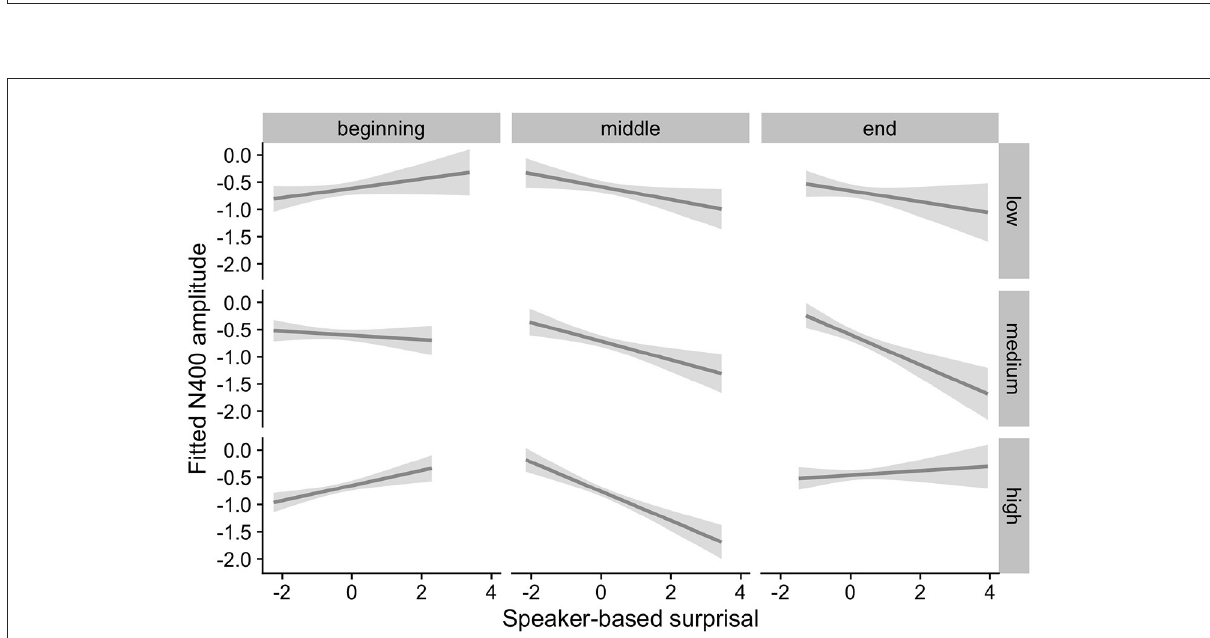
FIGURE8 Effects of IAF on changes in the relationship between speaker-based surprisal (z-transformed) and N400 amplitude over the course of Experiment 2. The figure visualizes partial effects as calculated using the remef package, adjusted for Prestimulus Amplitude and Frequency. Note that position in the experiment (operationalised via epoch in the statistical model) is trichotomised into beginning, middle and end for visualization purposes only; epoch was included in the model as a continuous predictor. The same holds for the individual differences variables, which are trichotomised for visualization purposes but were entered into the statistical models as a continuous predictors. Shaded areas indicate 95% confidence